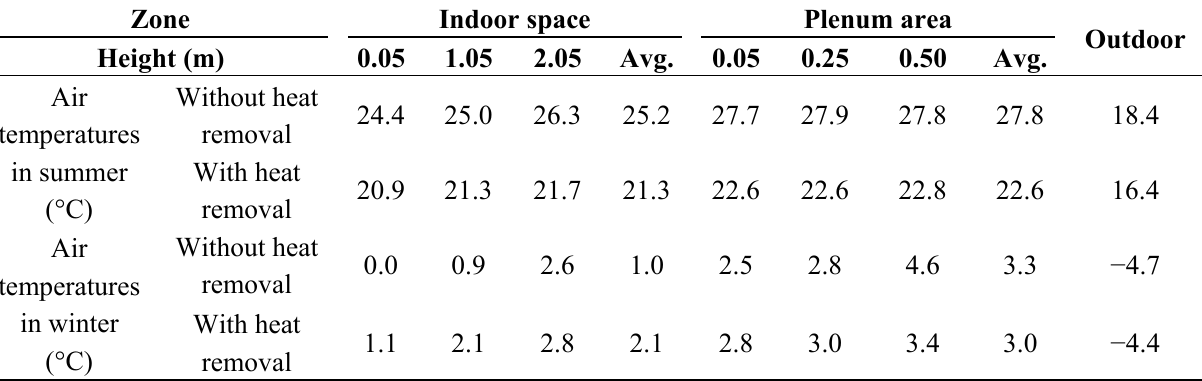
Table 2. Air temperatures of the indoor space and plenum with and without the ATOS. Zone Indoor space Plenum area Height